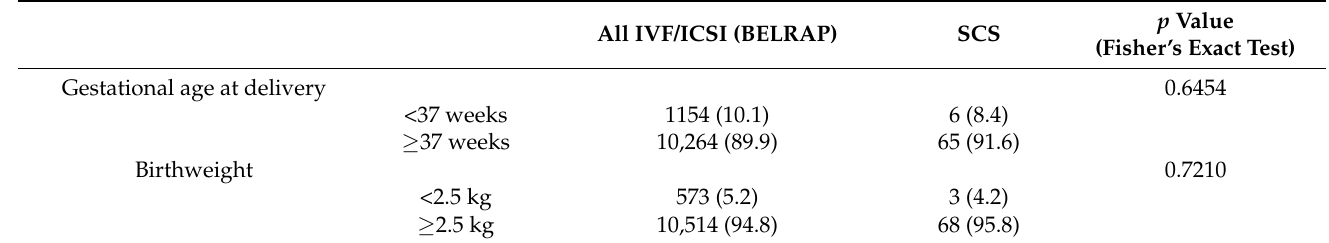
Table 2. Preterm birth and low birthweight comparison between SCS and all IVF/ICSI BELRAP singletons after frozen embryo transfer—number (%).